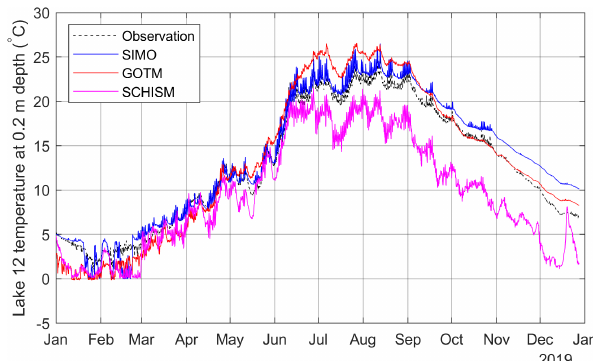
Figure 15. Comparison of the near-surface water temperature for SIMO, GOTM, and SCHISM for the period 1 January–27 Decem- ber